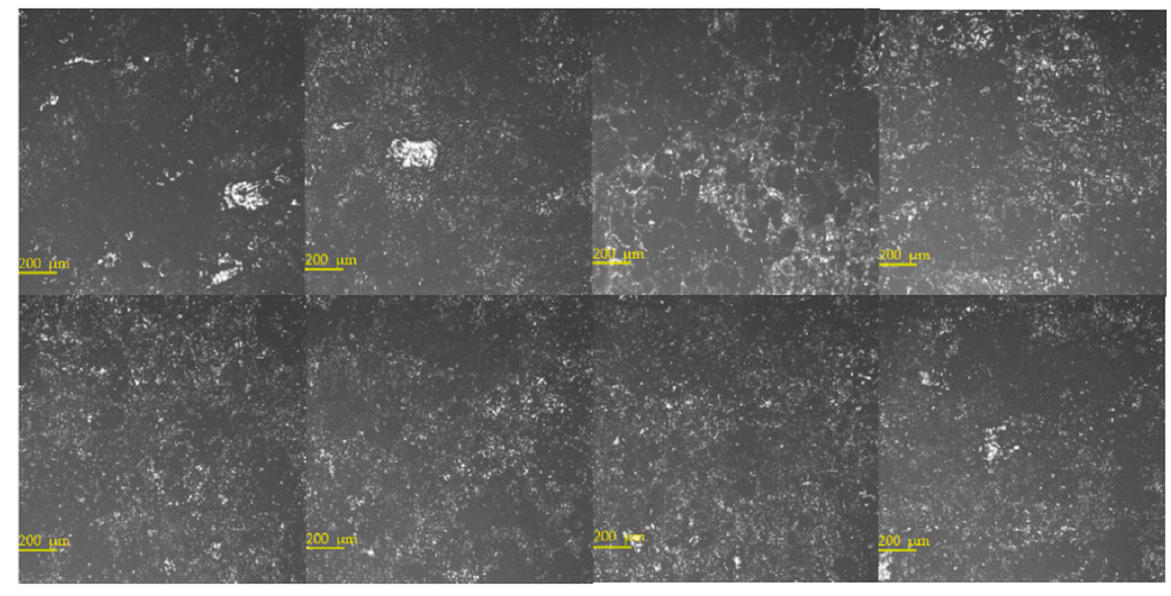
Figure 8. Experimental data samples.